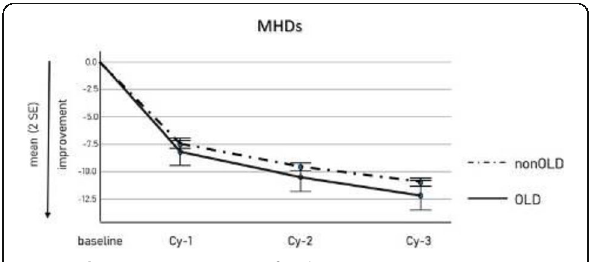
Fig. 1 (abstract A42). See text for description.